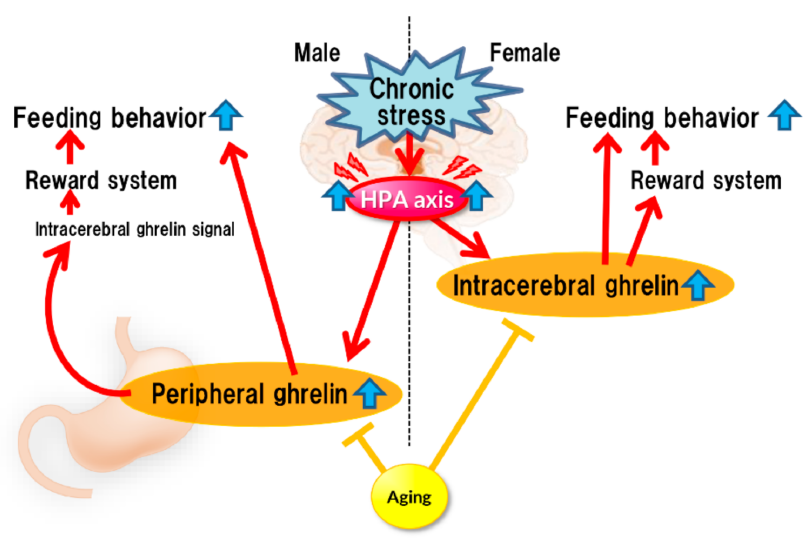
Figure 2. Chronic